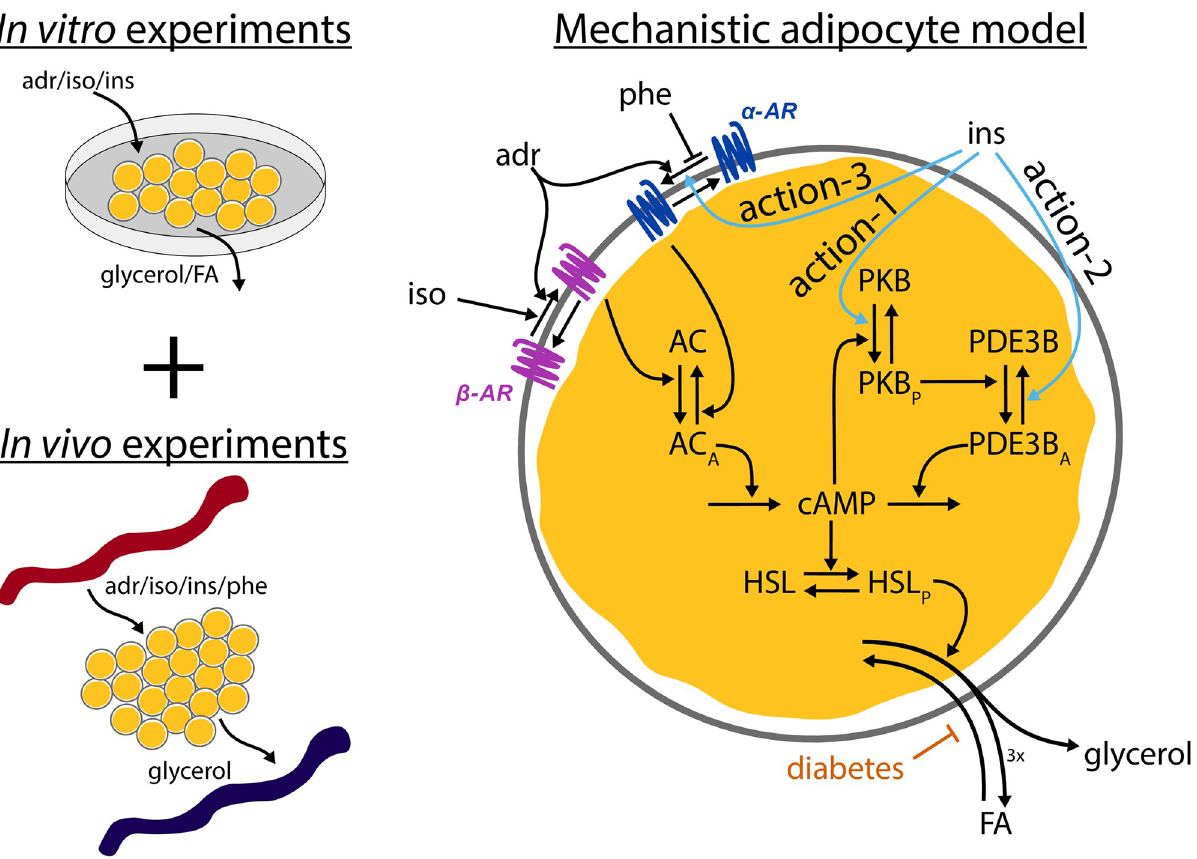
Fig 1. The system under study. Data from both in vitro and in vivo experiments of lipolysis control by insulin, adrenergic stimulus, and phentolamine were combined to create a first mechanistic model of lipolysis, under both non-diabetic and type 2 diabetic conditions. The model responds to stimuli with adrenaline (adr), isoproterenol (iso), insulin (ins), and phentolamine (phe), initiating signalling cascades through key proteins leading to release of fatty acids (FA) and glycerol. Adrenaline affects both β -adrenergic receptors ( β -AR) and α -adrenergic receptors ( α -AR), while iso only affects β -AR. Ins gives rise to three different insulin actions: action-1) an anti-lipolytic effect of insulin via protein kinase B (PKB) and phosphodiesterase 3B (PDE3B), action-2) a positive lipolytic effect via PDE3B at high insulin concentrations, and action-3) an anti-lipolytic effect of insulin via α -adrenergic receptors.